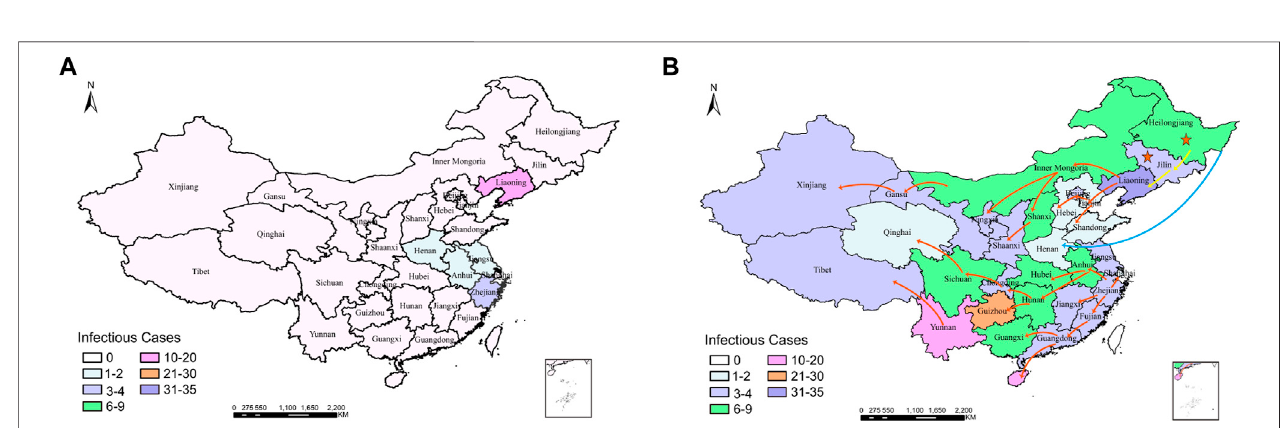
FIGURE9|(A) GeographicdistributionofASFVcasesinmainlandChinafromAugust1stto31st,2018. (B) GeographicdistributionofASFVcasesbyAugust31st, 2019, and inference of the most likely transmission map of ASFV based on the spatiotemporal backward detection algorithm.